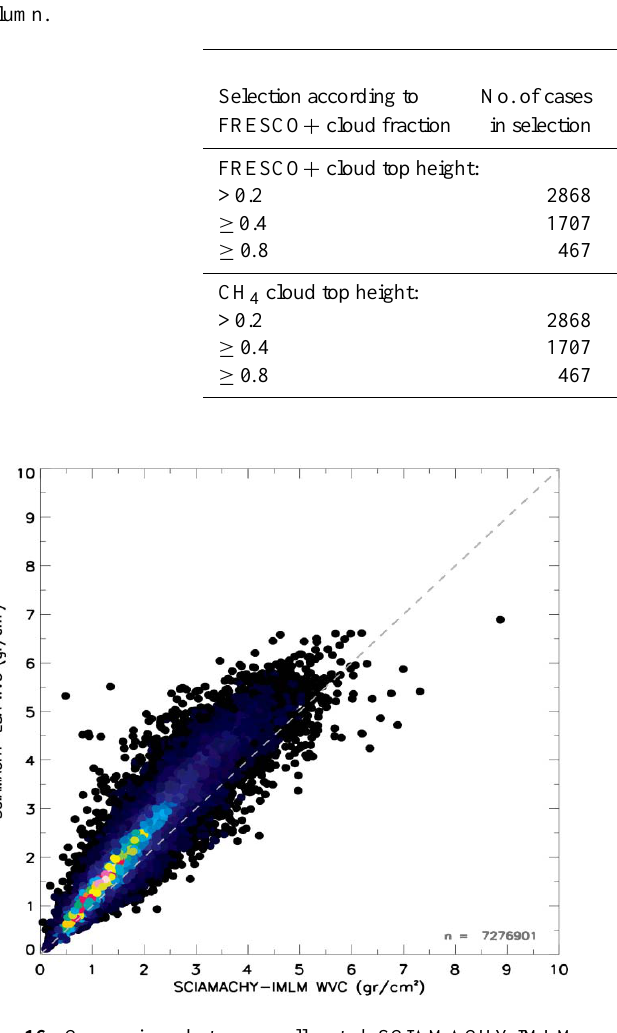
Fig. 16. Comparison between collocated SCIAMACHY-IMLM Figure 16. Comparison between collocated SCIAMACHY-IMLM and SCIAMACHY-ESA and SCIAMACHY-ESA WVC amounts for June 2009. The WVC amounts for June 2009. The SCIAMACHY-ESA WVC measurements and cloud cover SCIAMACHY-ESA WVC measurements and cloud cover amounts are averaged over the SCIAMACHY-IMLM ground pixel size. amounts are averaged over the SCIAMACHY-IMLM ground pixel size. Cases included in the Cases included in the selection are for SCIAMACHY-IMLM signal selection are for SCIAMACHY-IMLM signal level strength larger or equal to 100 BU/px and level strength larger than or equal to 100BUpx − 1 and are limited to land measurements during cloud-free conditions where SPICI (to- are limited to land measurements during cloud free conditions where SPICI (together with the gether with the additional methane cloud filter) and the averaged additional methane cloud filter) and the averaged ESA cloud fraction amounts are zero. A ESA cloud fraction amounts are zero. A mean bias of 0.39gcm − 2 mean bias of 0.39 g/cm 2 is found with a standard deviation of 0.35g/cm 2 . is found with a standard deviation of 0.35gcm − 2